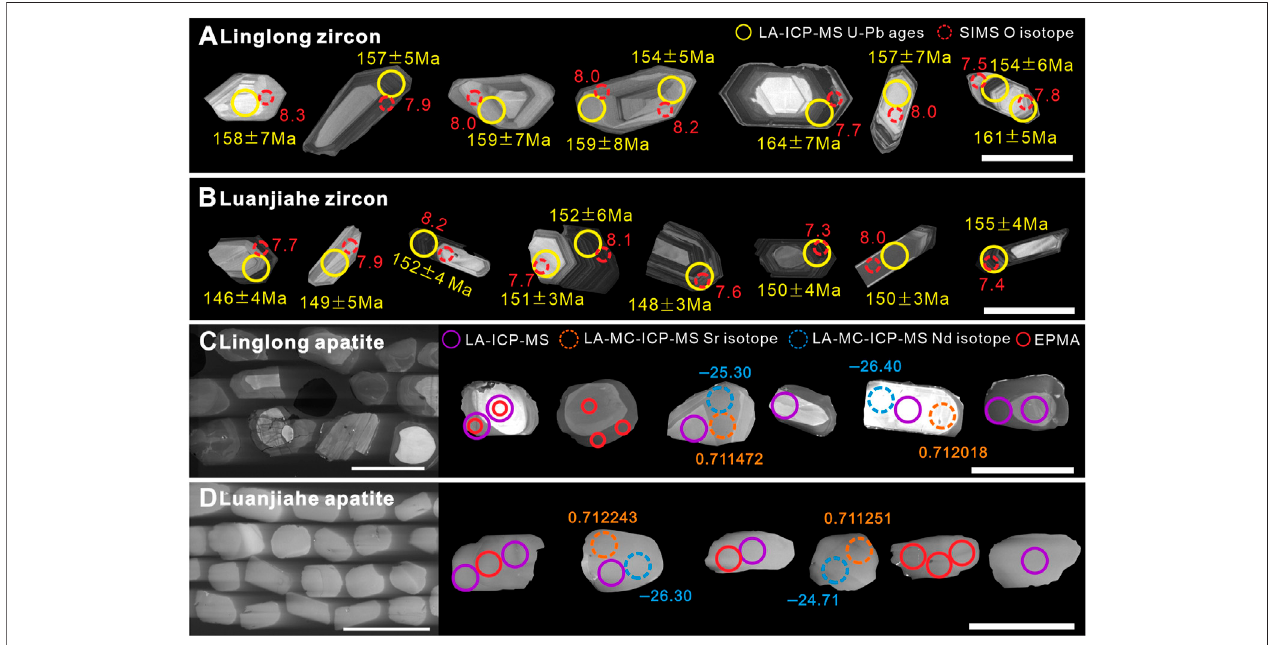
FIGURE 4 | (A,B) Cathodoluminescence (CL) images of representative zircons, with the ages and δ 18 O values given nearby (C,D) Phosphorescence effect and Cathodoluminescence (CL) images of representative apatites, with the initial 87 Sr/ 86 Sr ratios and ε Nd (t) values given nearby. The scale bar is 200 μ m.